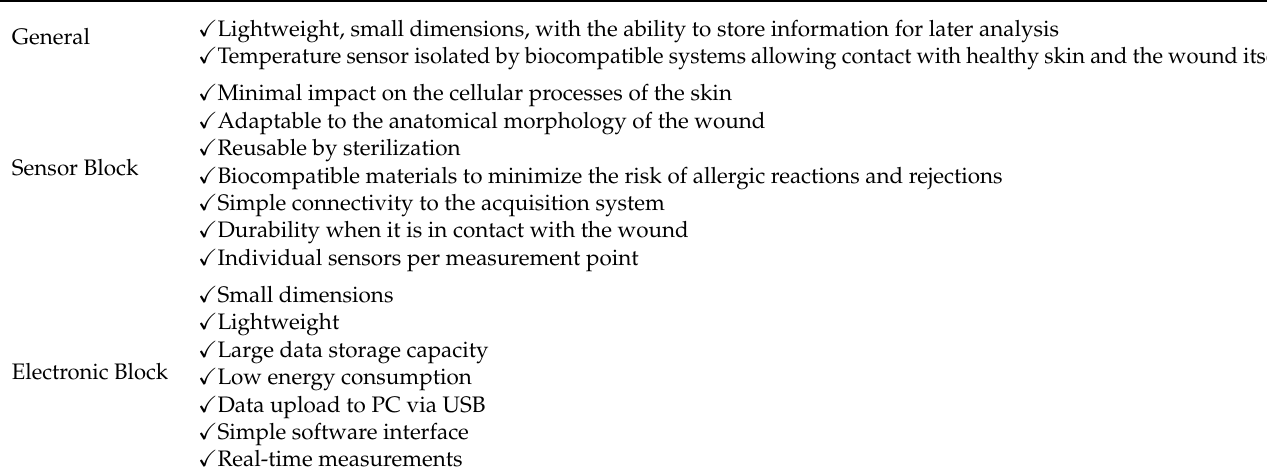
Table 1. Characteristics of the